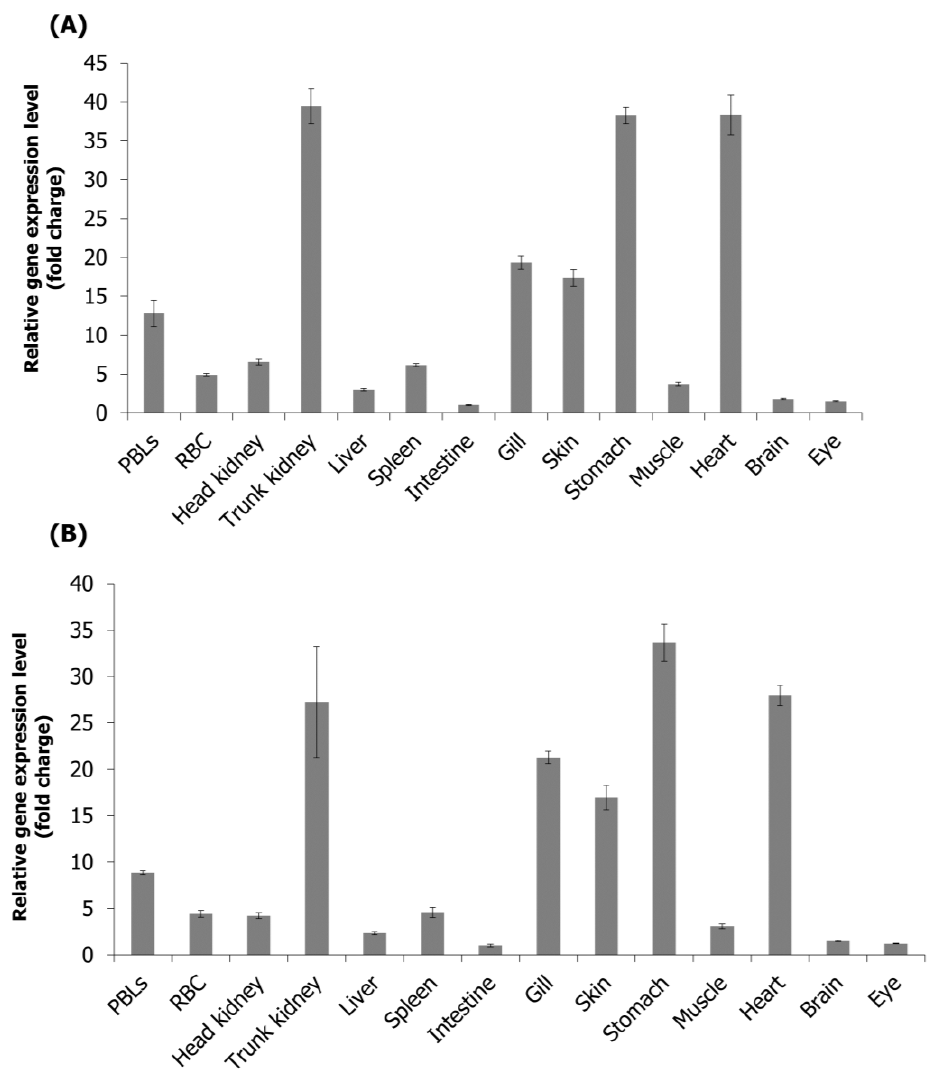
Figure 4. Detection of RPS27A ( A ) and S30FAU ( B ) genes in different tissues of healthy starry flounder by real-time PCR. EF-1 α was used for normalizing the real-time PCR results. Data are presented as the mean ± SD from three independent cDNA samples with three replicates from each sample.